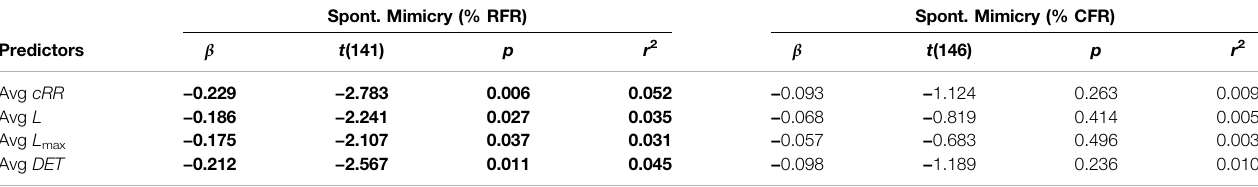
TABLE 7 | Regression Analyses [RQ4]. Features of instructed facial mimicry as predictors of the frequency of Spontaneous facial mimicry. The signi fi cant results are displayed in bold. Spont. Mimicry (%